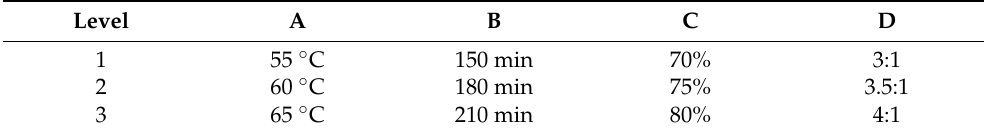
Table 7. Orthogonal test factor selection level